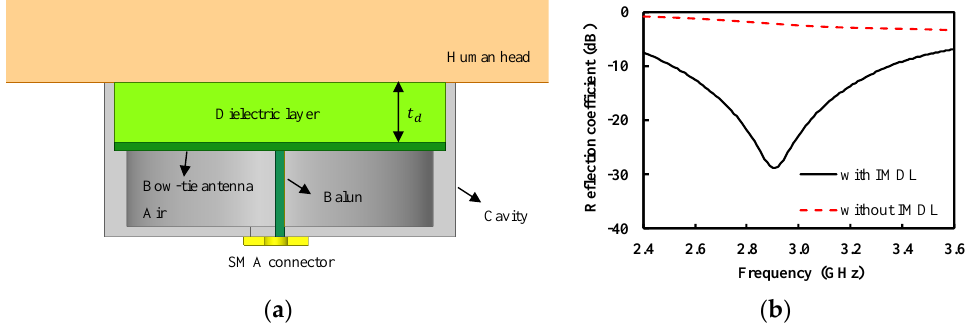
Figure 5. Cavity-backed bow-tie antenna for a human head ( a ) cross-sectional view; ( b ) simulated reflection coefficient.